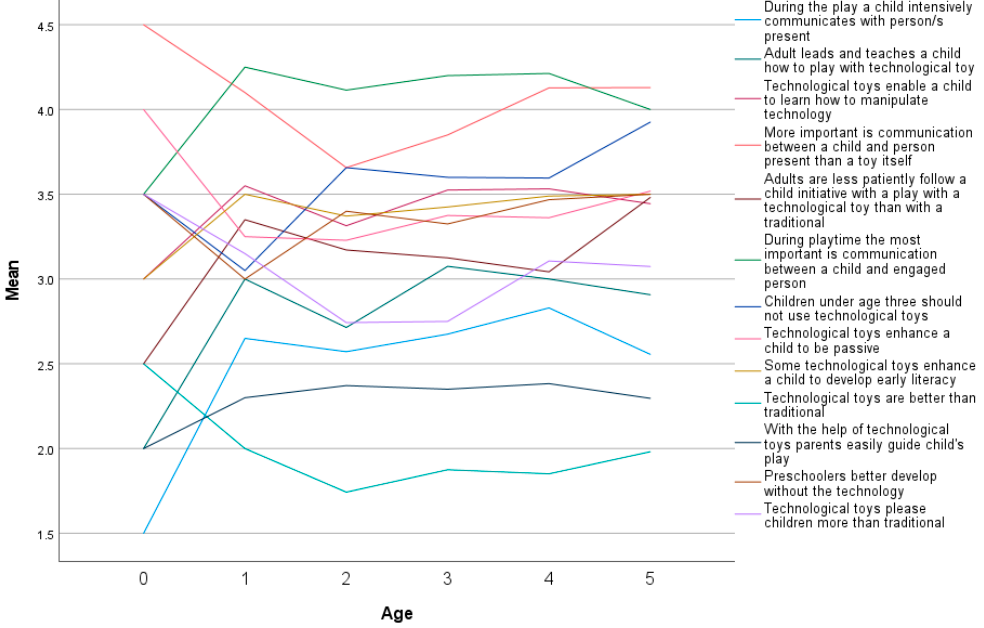
Figure 4. Parents perceive characteristics of a child’s play with traditional and digital toys according to the child’s age.